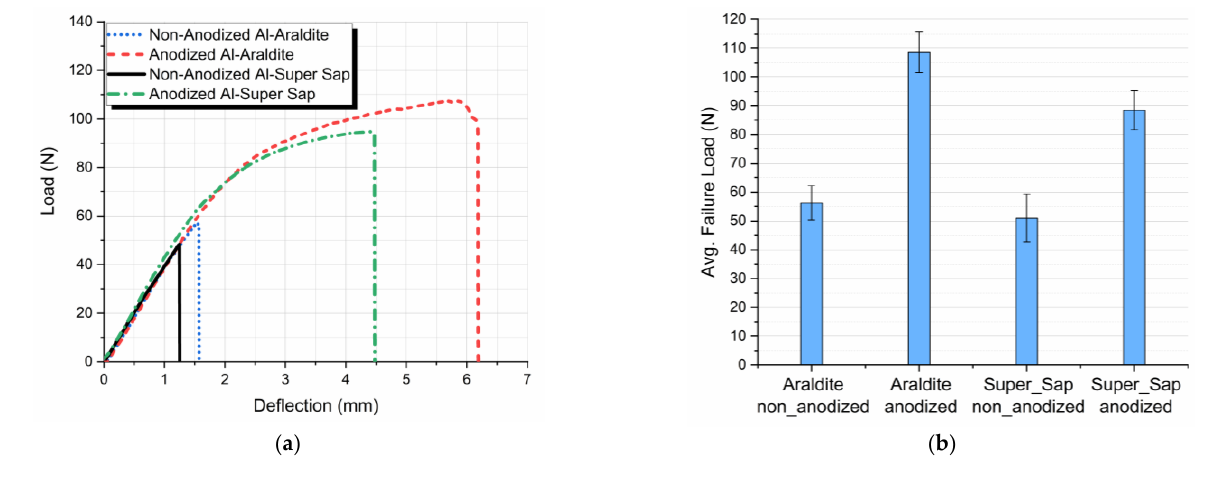
Figure 8. Effect of aluminum adherends anodization on the aluminum single-lap joints bonded with Araldite and Super Sap adhesive three-point bending behavior; ( a ) load-deflection curve, ( b ) bar diagram for the joints’ average flexural failure load.